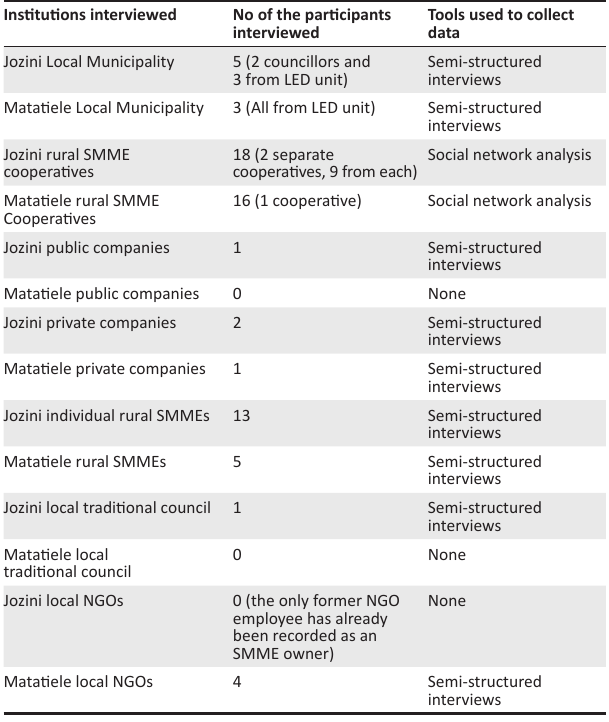
TABLE 2: Interview table showing participants and tools used in this